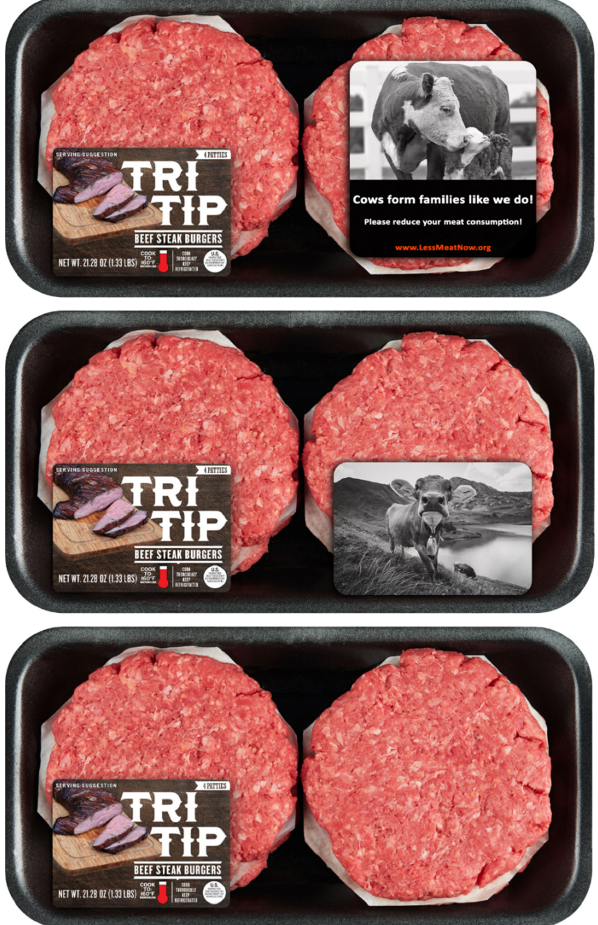
Figure 2. The burger beef patties product (Bottom: Original packaging, Middle: Just cow packaging, Top: Example of anthropomorphic sticker packaging—Pro-social anthropomorphism).